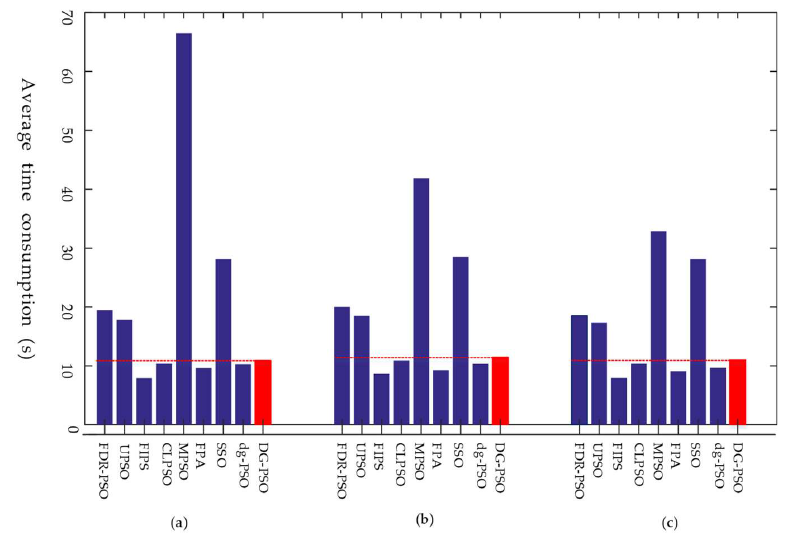
Figure 5. Average time consumption. ( a ) F8, multimodal; ( b ) F10, rotated unimodal; ( c ) F14, shifted multimodal.